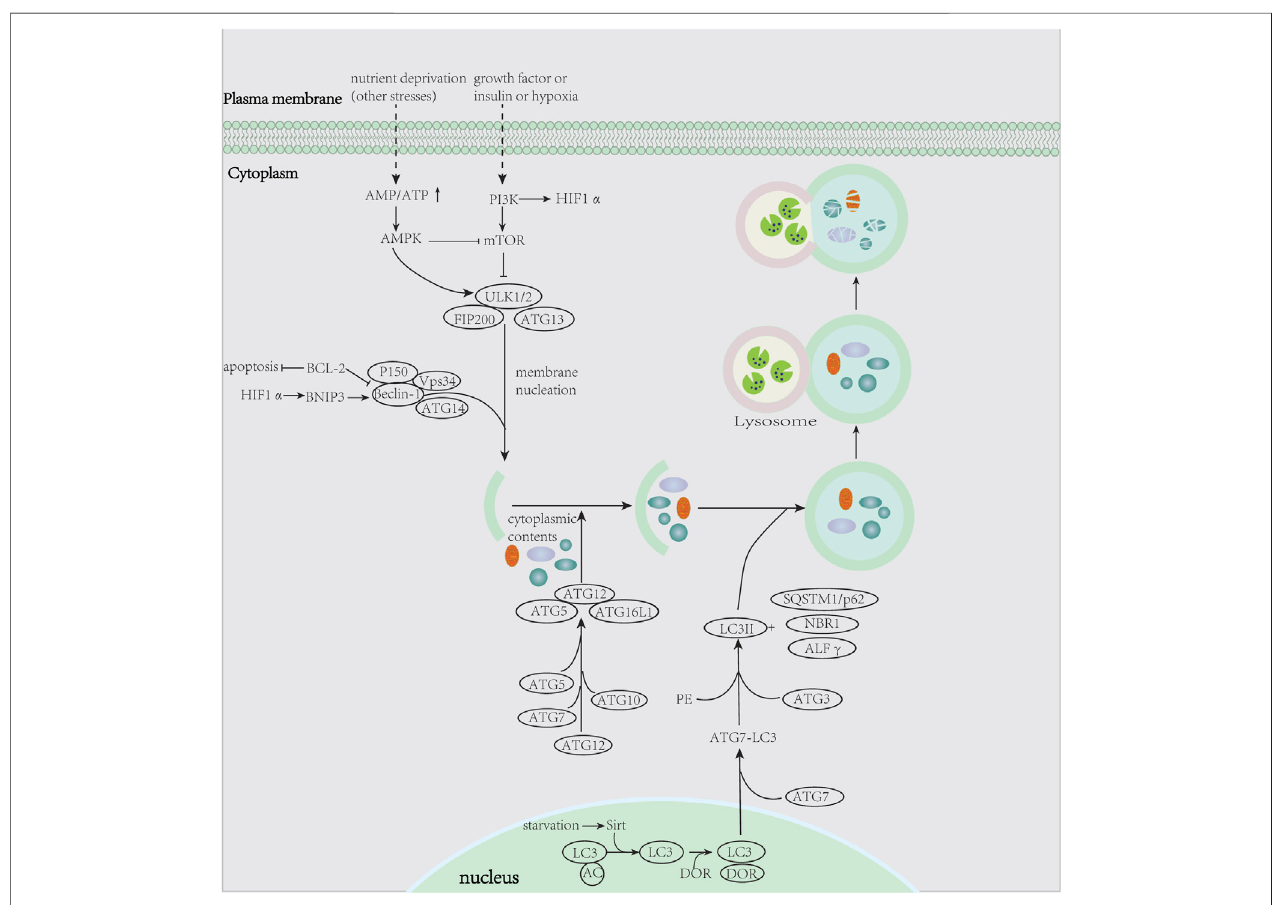
FIGURE 1 | Summary of the process of